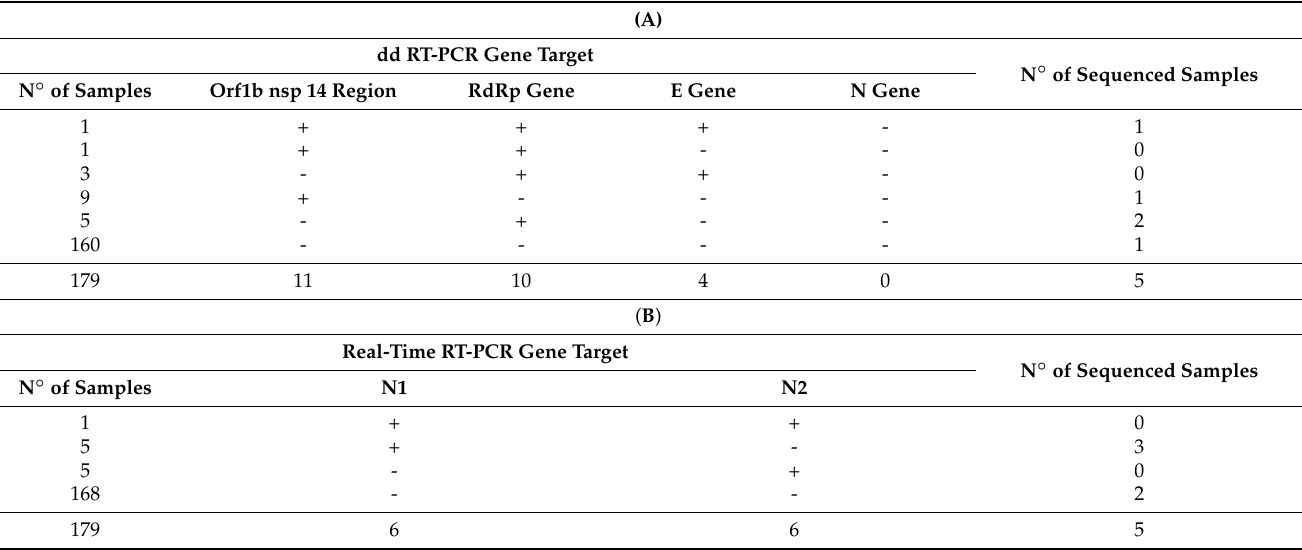
Table 2. Summary of ddPCR (A) and real-time RT-PCR (B) study results. (A) Summary of dd RT-PCR results. (B) Summary of real-time RT-PCR